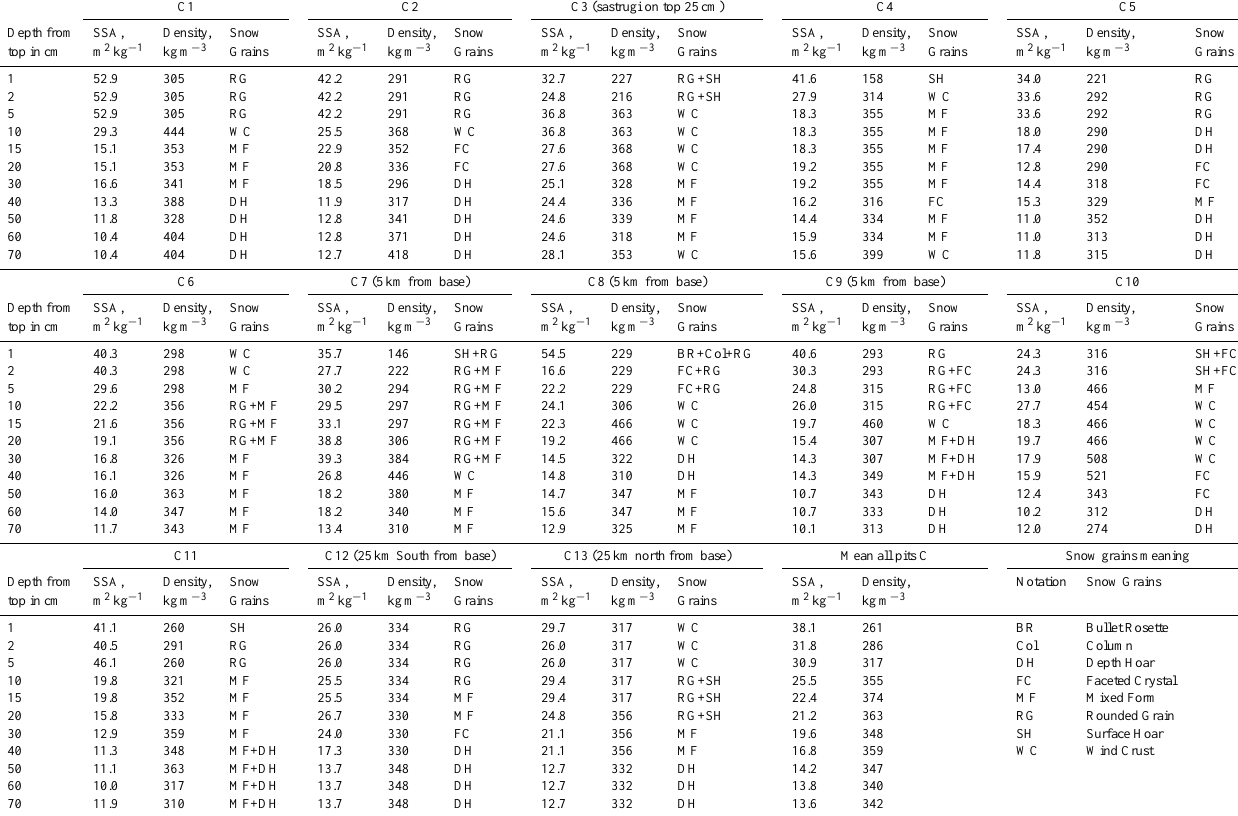
Table A1. SSAs and densities used in DISORT, group C. C1 C2